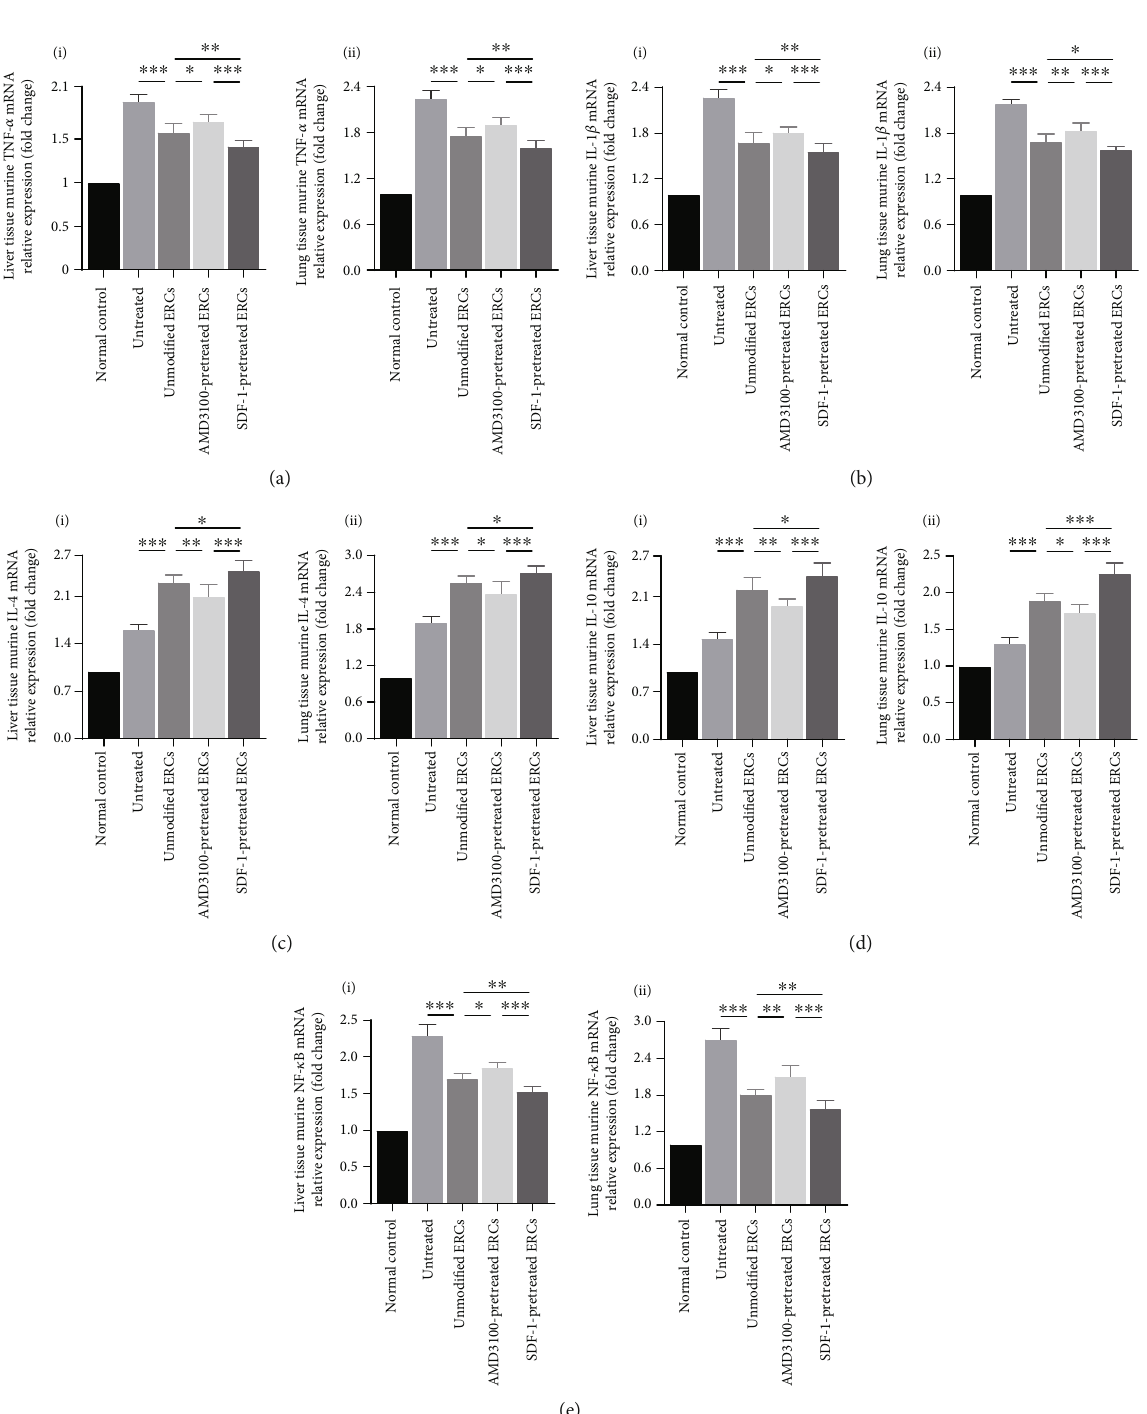
Figure 4: Pretreatment with SDF-1 further enhanced the anti-in fl ammatory e ff ect of ERCs in the process of sepsis. The mRNA expression levels of murine TNF- α (a), IL-1 β (b), IL-4 (c), IL-10 (d), and NF- κ B (e) in liver and lung tissues. Statistical analysis was performed by one-way ANOVA followed by the LSD test, n = 6 . ∗ p < 0 : 05 , ∗∗ p < 0 : 01 , and ∗∗∗ p < 0 : 001 . Bar graphs represent mean ± SD . Abbreviation: ERCs: endometrial regenerative